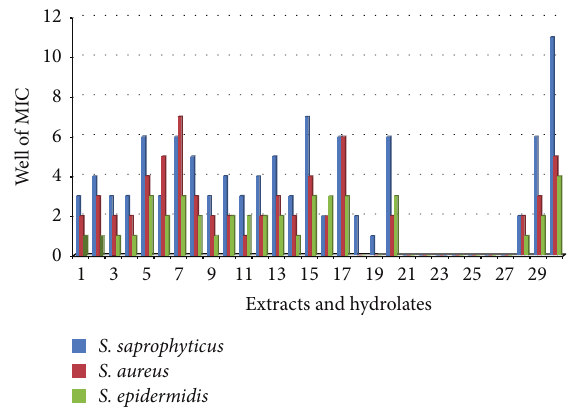
Figure 2: MICs of extracts and hydrolates against gram posi-